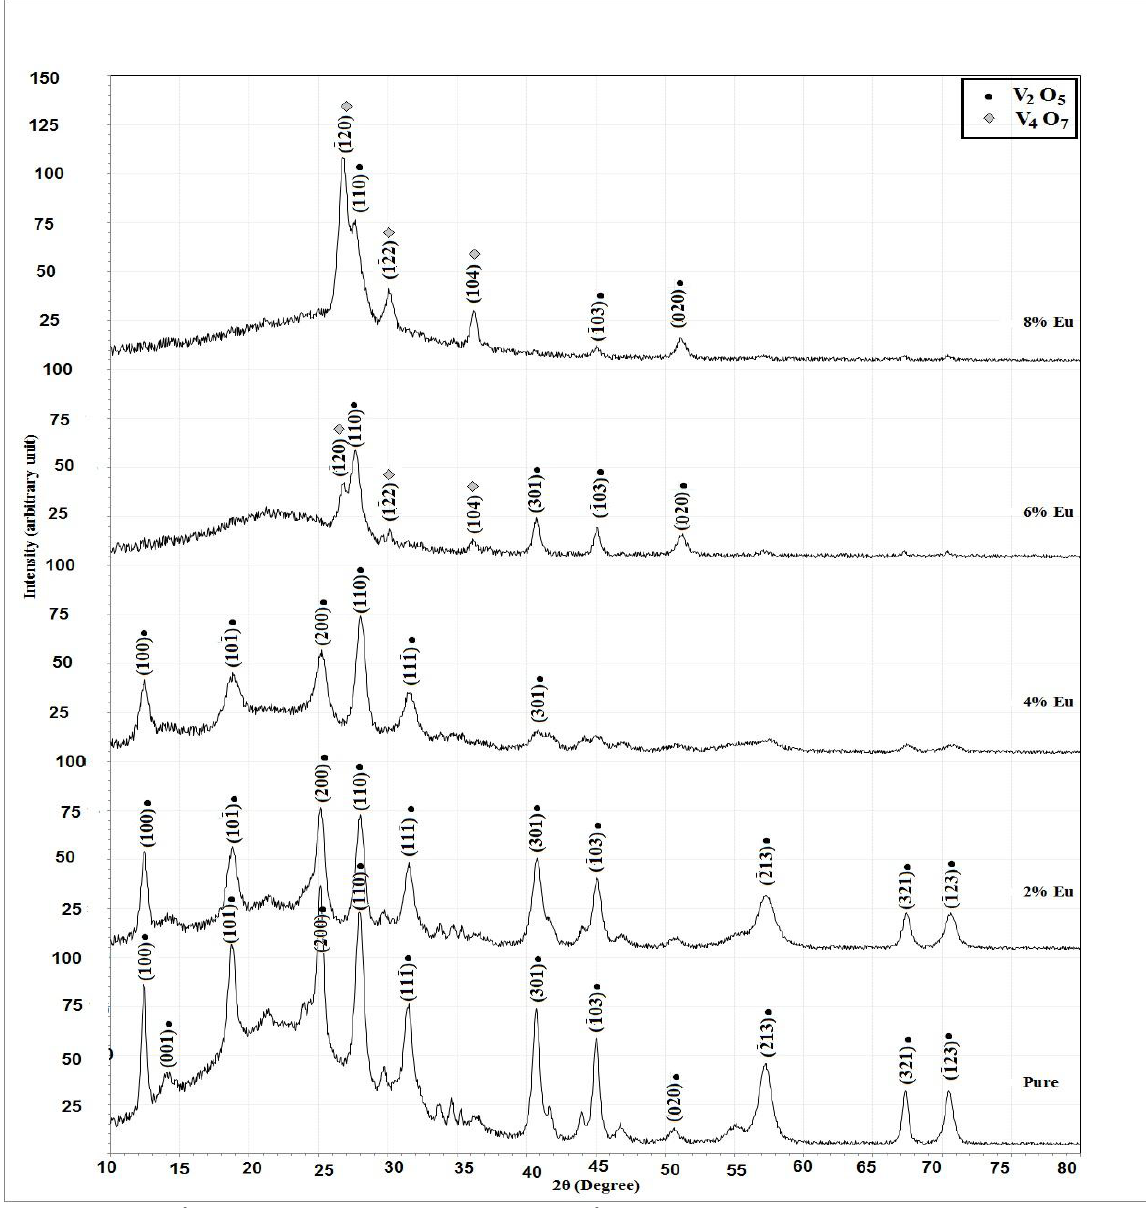
Fig.1: XRD for V